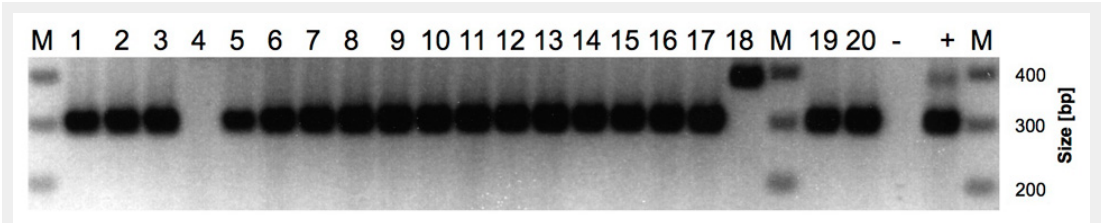
Agarose gel electrophoresis analysis of vanA and vanB PCR screening of VRE isolates. Amplicon sizes: vanA : 377 bp (lane 18); vanB : 298 bp (lanes 1–17, 19, 20). Lanes 1–18: VRE isolates from patient samples (patients 1–17, lanes 4 and 5 are both isolates from patient 4); lanes 19–20: VRE isolates from environmental samples (keyboard and defibrillator); lane –: negative control; lane +: vanA and vanB positive control. Lane M: size